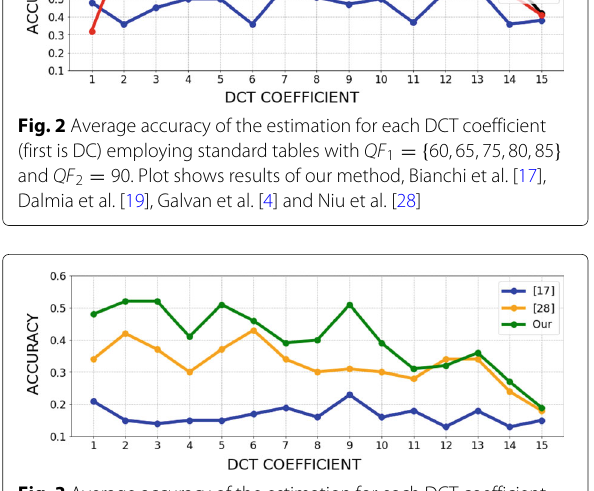
Fig. 3 Average accuracy of the estimation for each DCT coefficient (first is DC) employing standard tables with QF 1 = { 55,60,65,75,80,85,90,95 } and QF 2 = 80. Plot shows results of our method, Bianchi et al. [17] and Niu et al. [28]